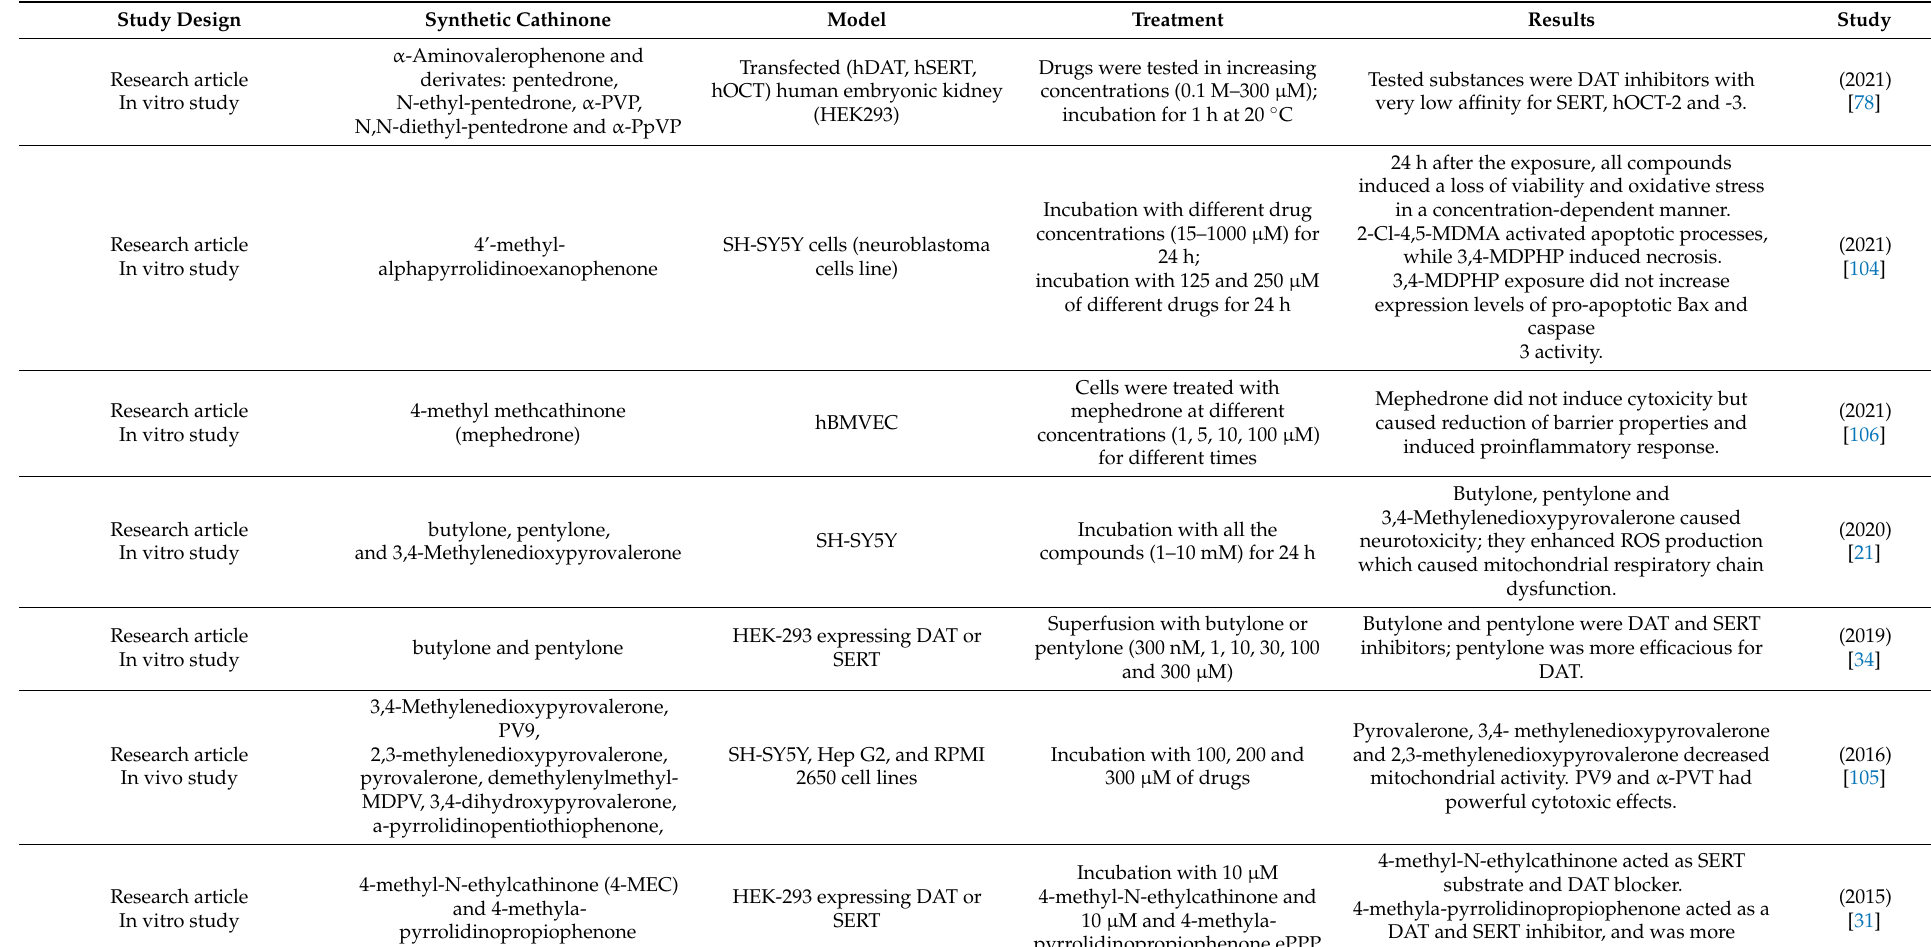
Table 2. Characteristics of eligible studies (in vitro studies of human